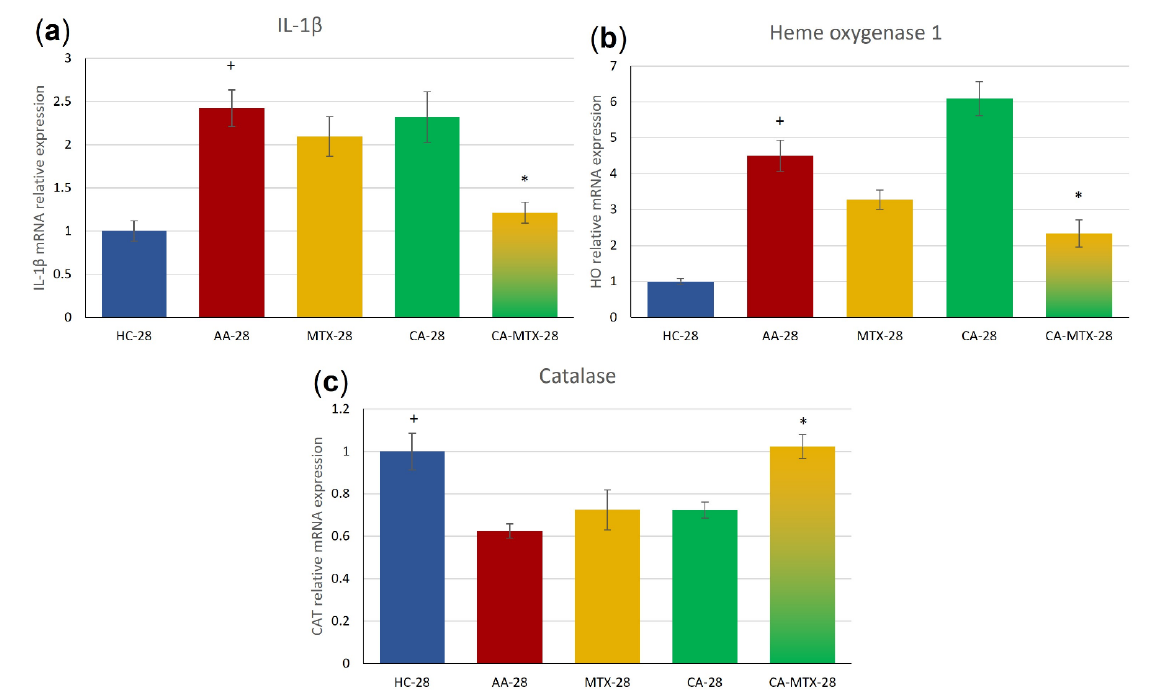
Figure 6. Relative mRNA expression of IL-1 β ( a ), HO-1 ( b ) and CAT ( c ). + HC vs. AA, * AA vs. MTX/C/CA- MTX, p ≤ 0.05.